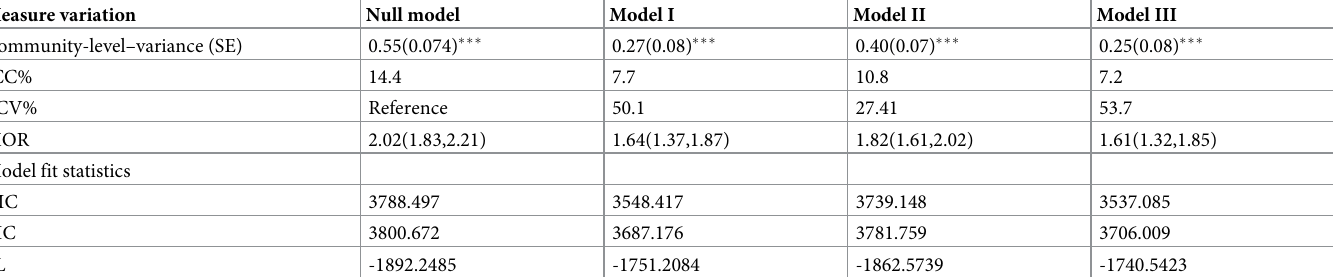
Table 2. Community-level variance and model comparison of multilevel logistic regression model predicting under-weight among lactating mothers, Ethiopia